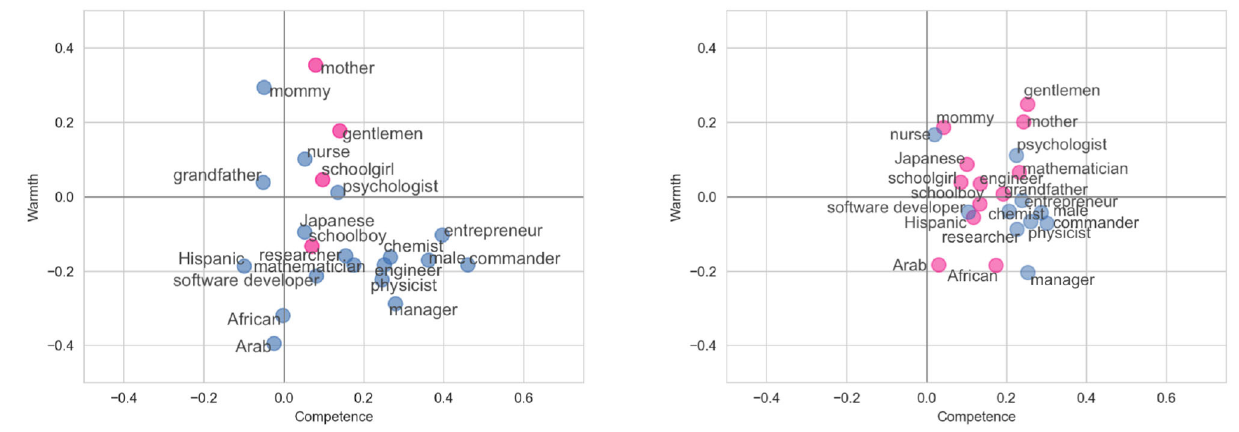
FIGURE 1 | (Left) Plotting the average of the StereoSet stereotypes using the proposed method. (Right) Plotting the stereotypes using the baseline method of McKee et al. (2021). Groups which are correctly categorized according to the predictions of the literature are shown in blue, while those which are incorrectly categorized are marked with